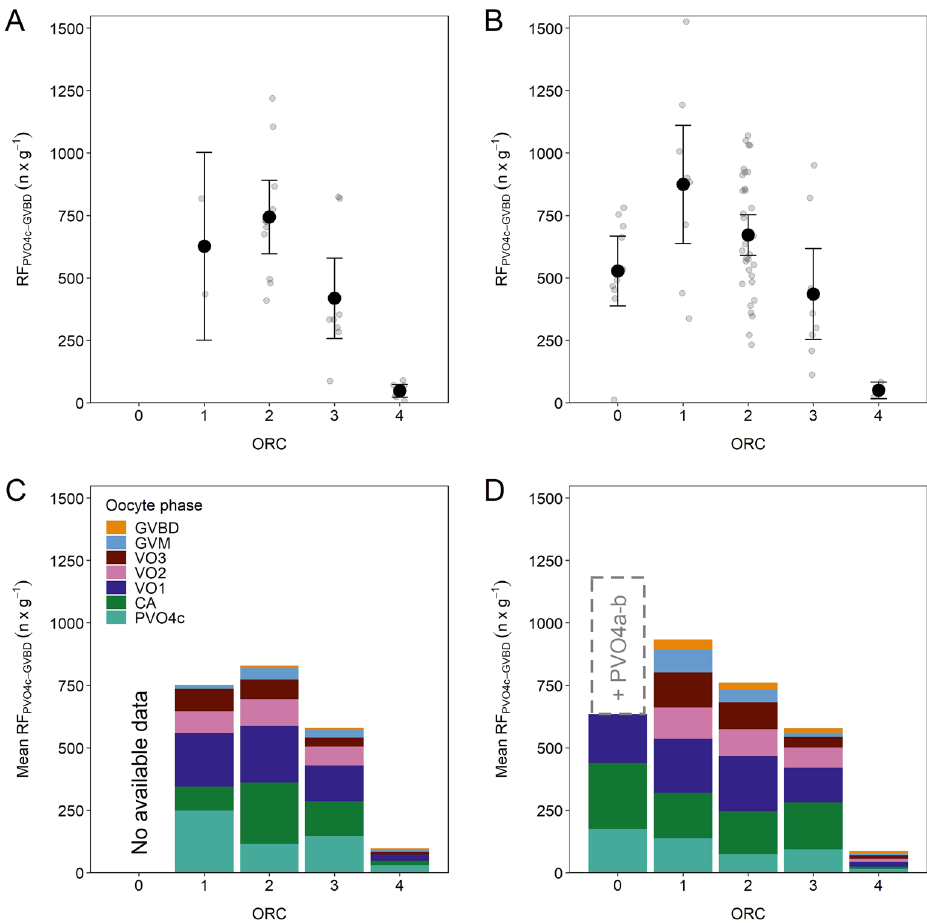
Figure 9. Mean (± 95% confidence interval) RF i (relative fecundity) at PVO4c to GVBD in 2018 ( A ) and 2019 ( B ), and the sum of grand mean RF i at PVO4c to GVBD in 2018 ( C ) and 2019 ( D ), split in all cases by oocyte ratio category (ORC). Grey circles in ( A ) and ( B ) represent the span in individual RF i . For ( C ) and ( D ) the contribution of each oocyte phase is detailed within the histogram. Dashed column in ( D ) indicates the RF i when PVO4a and PVO4b are added to the fecundity